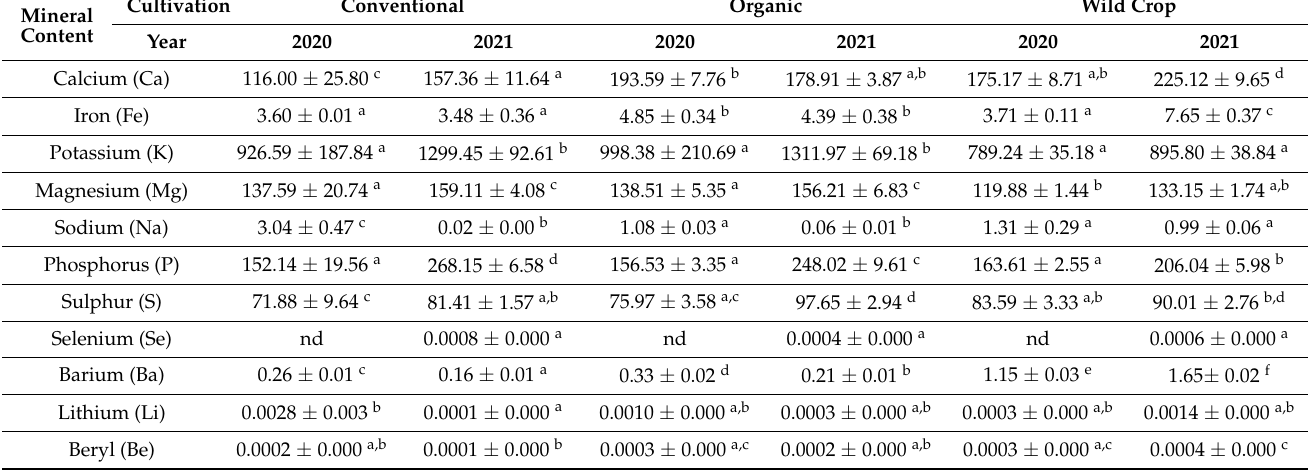
Table 2. Selected minerals in fruits of raspberries from conventional and organic practices as well as those wild grown (mg 100 g − 1